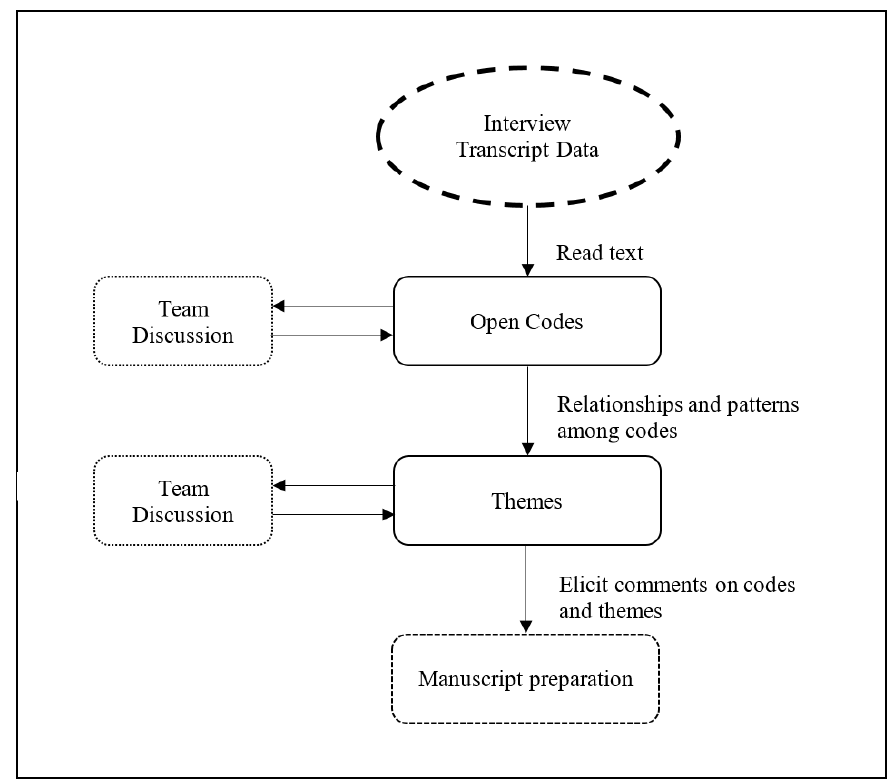
Figure 1. Flowchart of thematic analysis approach.